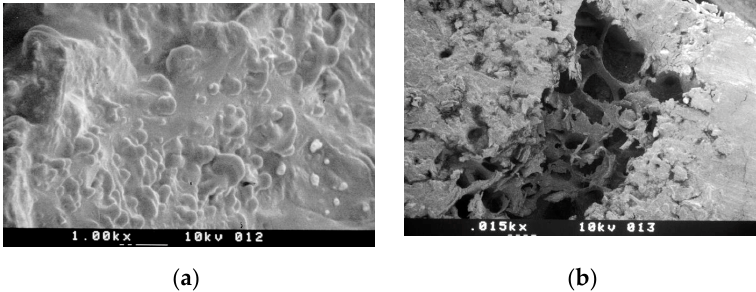
Figure 5. SEM micrograph magnifications of an ultrasonic implant site preparation: ( a ) Textured appearance of the bone surface due to hemispheres, which represent the extremities of the collagen fibers. ( b ) The cancellous bone walls were cleaned, completely free of bone fragments. The architecture of the mineralized trabecular structure seemed well preserved and the bone trabeculae appeared precisely cut.